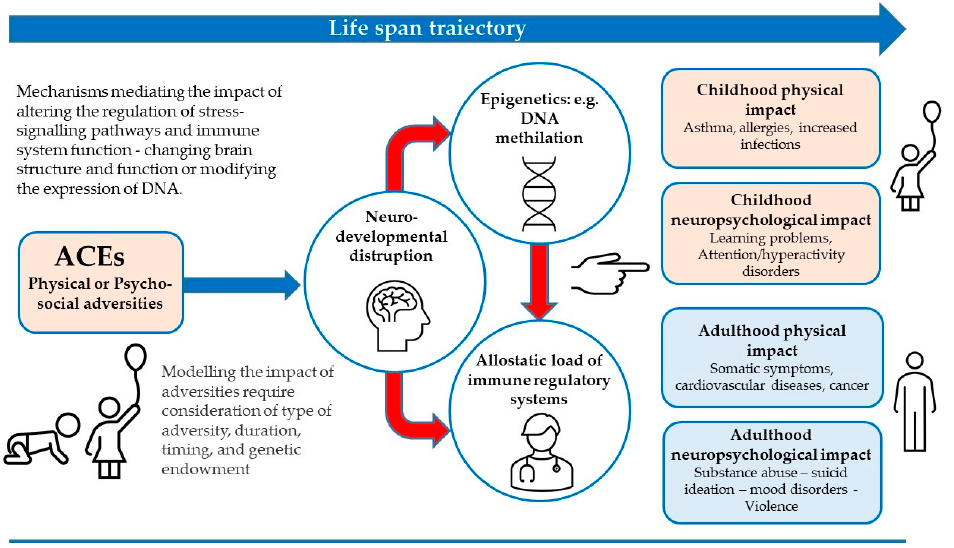
Figure 1. Impact of ACEs exposure and potential mechanisms for physical and/or neuro- Figure psychological facets in childhood and adulthood.